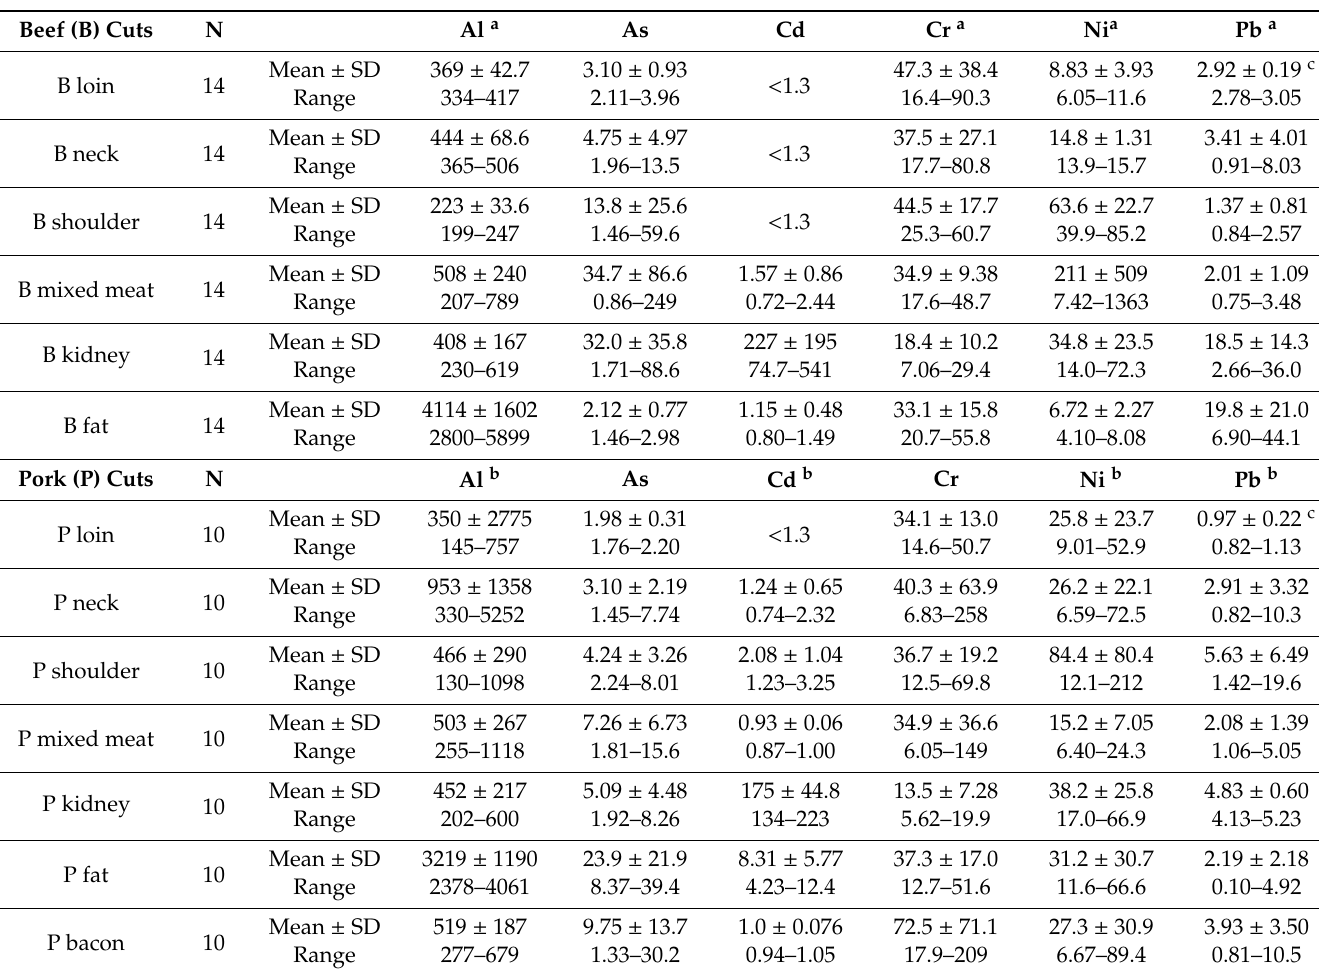
Table 4. Concentrations of trace and toxic elements ( µ g / kg; mean ± SD, min–max) in beef and pork cuts from markets of the Croatian